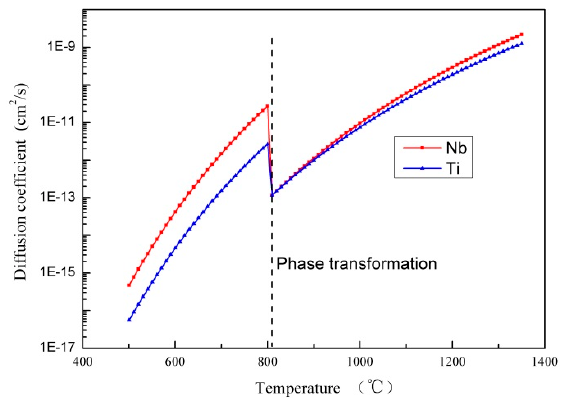
Figure 18. Diffusion coefficient of Nb and Ti as a function of temperature.